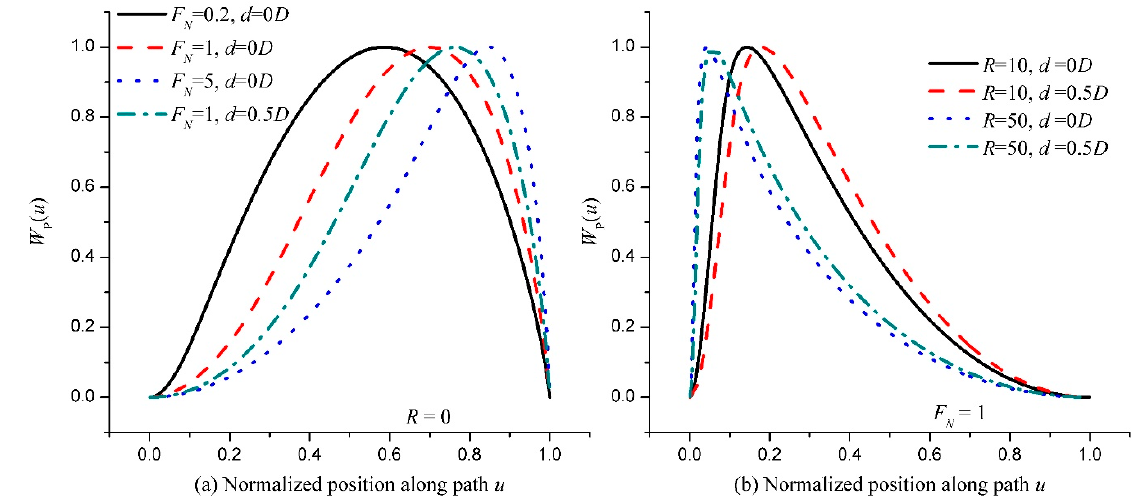
Figure 5. Normalized path-weighting function for the covariance of piston amplitude W P ( u ) for spherical waves. ( a ) Point sources with various F N ( F N = D 2 / λ L ) and d (the distance between aperture centers) values. ( b ) Distributed sources with various R ( R = D S L/DL S ) and d values when F N = 1.